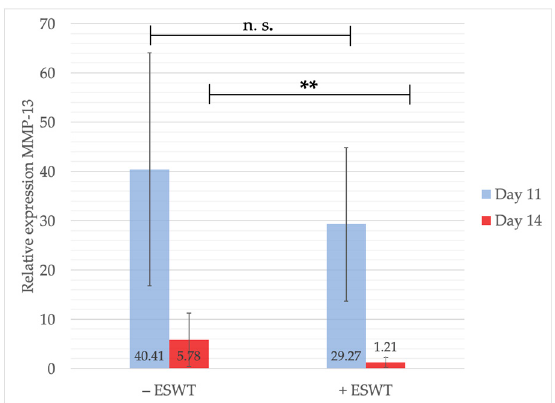
Figure 9. Gene expression analysis of MMP-13 via qPCR. Measurements were performed one and four days after ESWT-/sham-treatment. Slightly higher gene expression values could be detected within the control group on EDD-11. On EDD-14 statistically significant differences between treated and untreated groups were shown with a higher expression within the control group. Shown are means ± SD, n.s. = not significant, ** p < 0.05, EDD-11: Independent-Samples t -Test between experimental groups and untreated control, normally distributed, homogeneity of variance. EDD-14: inhomogeneity of variance.